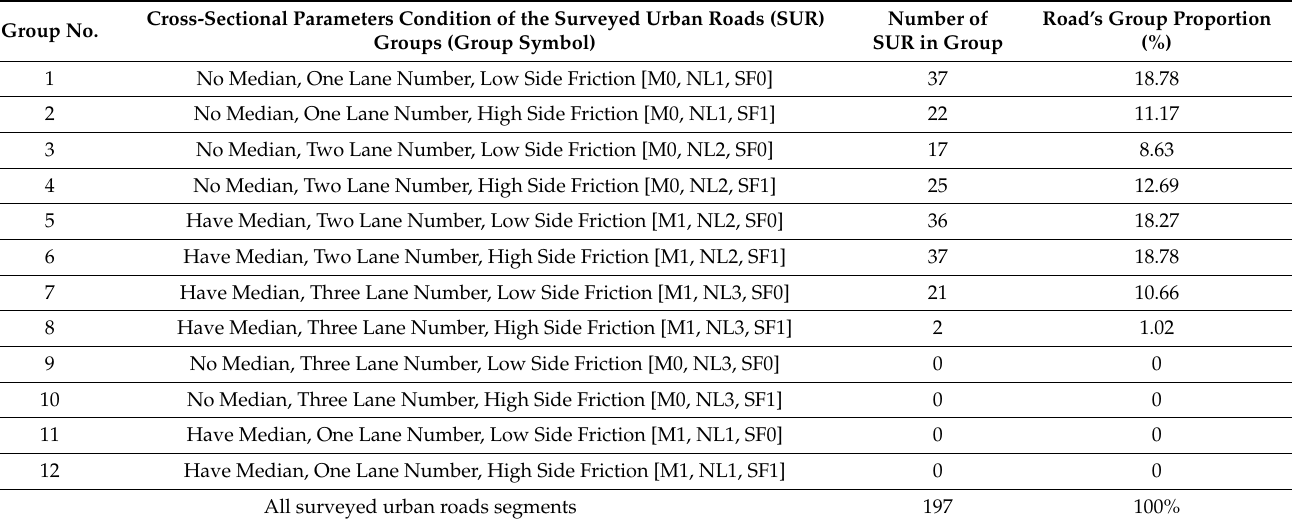
Table 3. Grouping the surveyed urban roads based on the cross-sectional